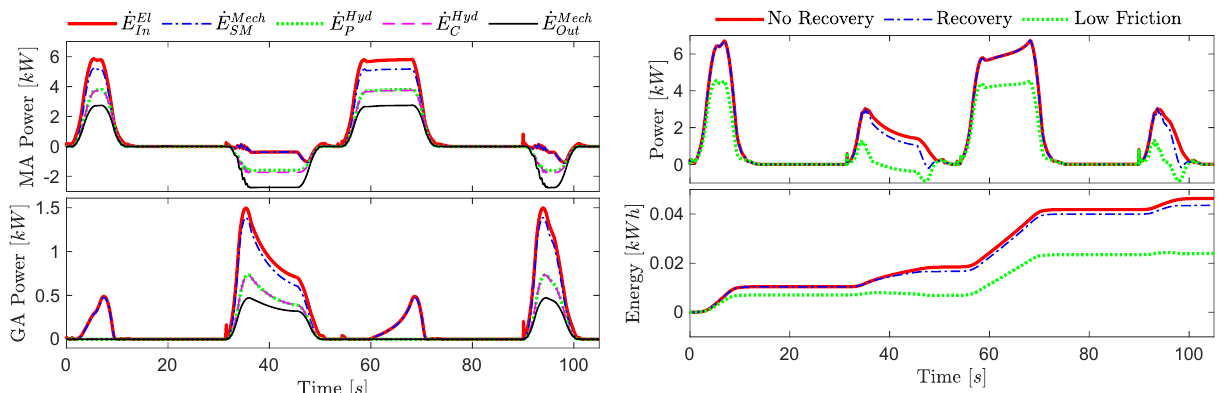
Figure 31: Power consumption of the main arm and guide arms SCCs.